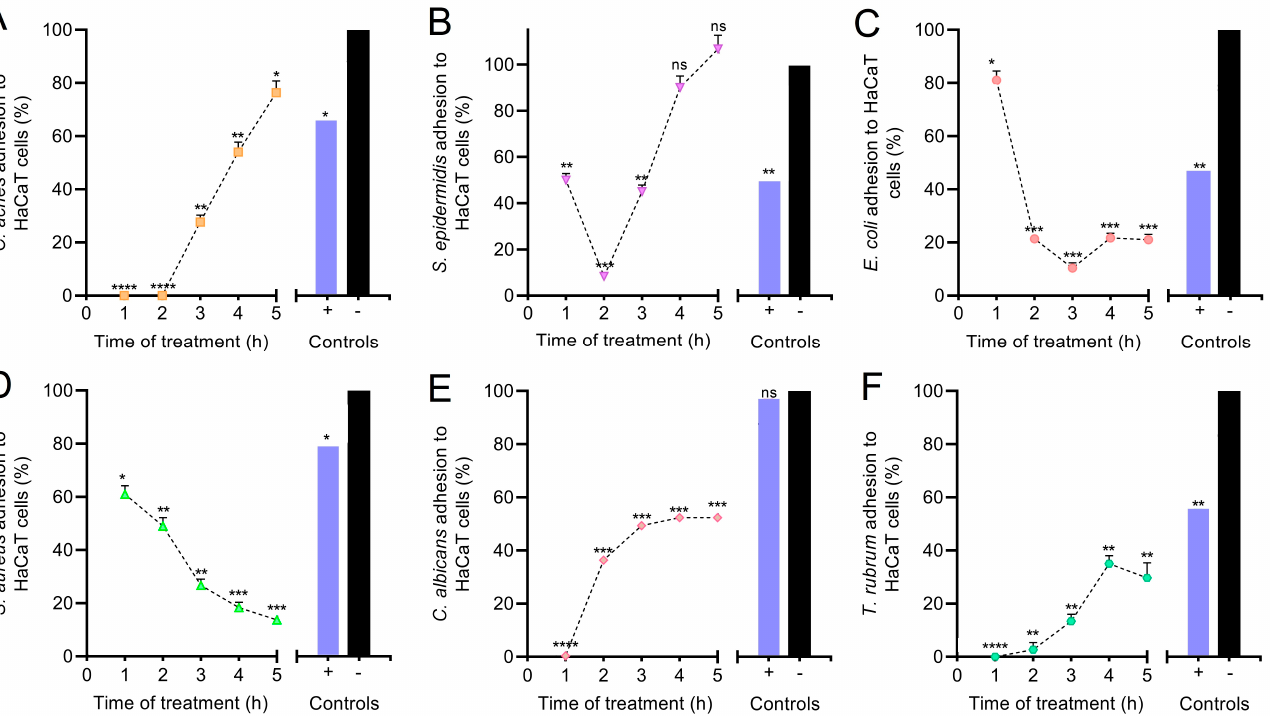
Figure 5. Percentage of microbial adhesion (mean ± SD) to persimmon extract rich in carotenoids (PEC)-treated HaCaT monolayer cells. PEC treatment at MIC/4 led to a significant decrease of microbial adhesion to HaCaT cells over time, as compared to the negative control (**** p < 0.0001, *** p < 0.001, ** p < 0.01, * p < 0.05, ns p > 0.05, ANOVA, and Dunnett’s post hoc test). Microorganisms: ( A ) Cutibacterium acnes , ( B ) Staphylococcus epidermidis , ( C ) Escherichia coli , ( D ) Staphylococcus aureus , ( E ) Candida albicans , and ( F ) Trichophyton rubrum .